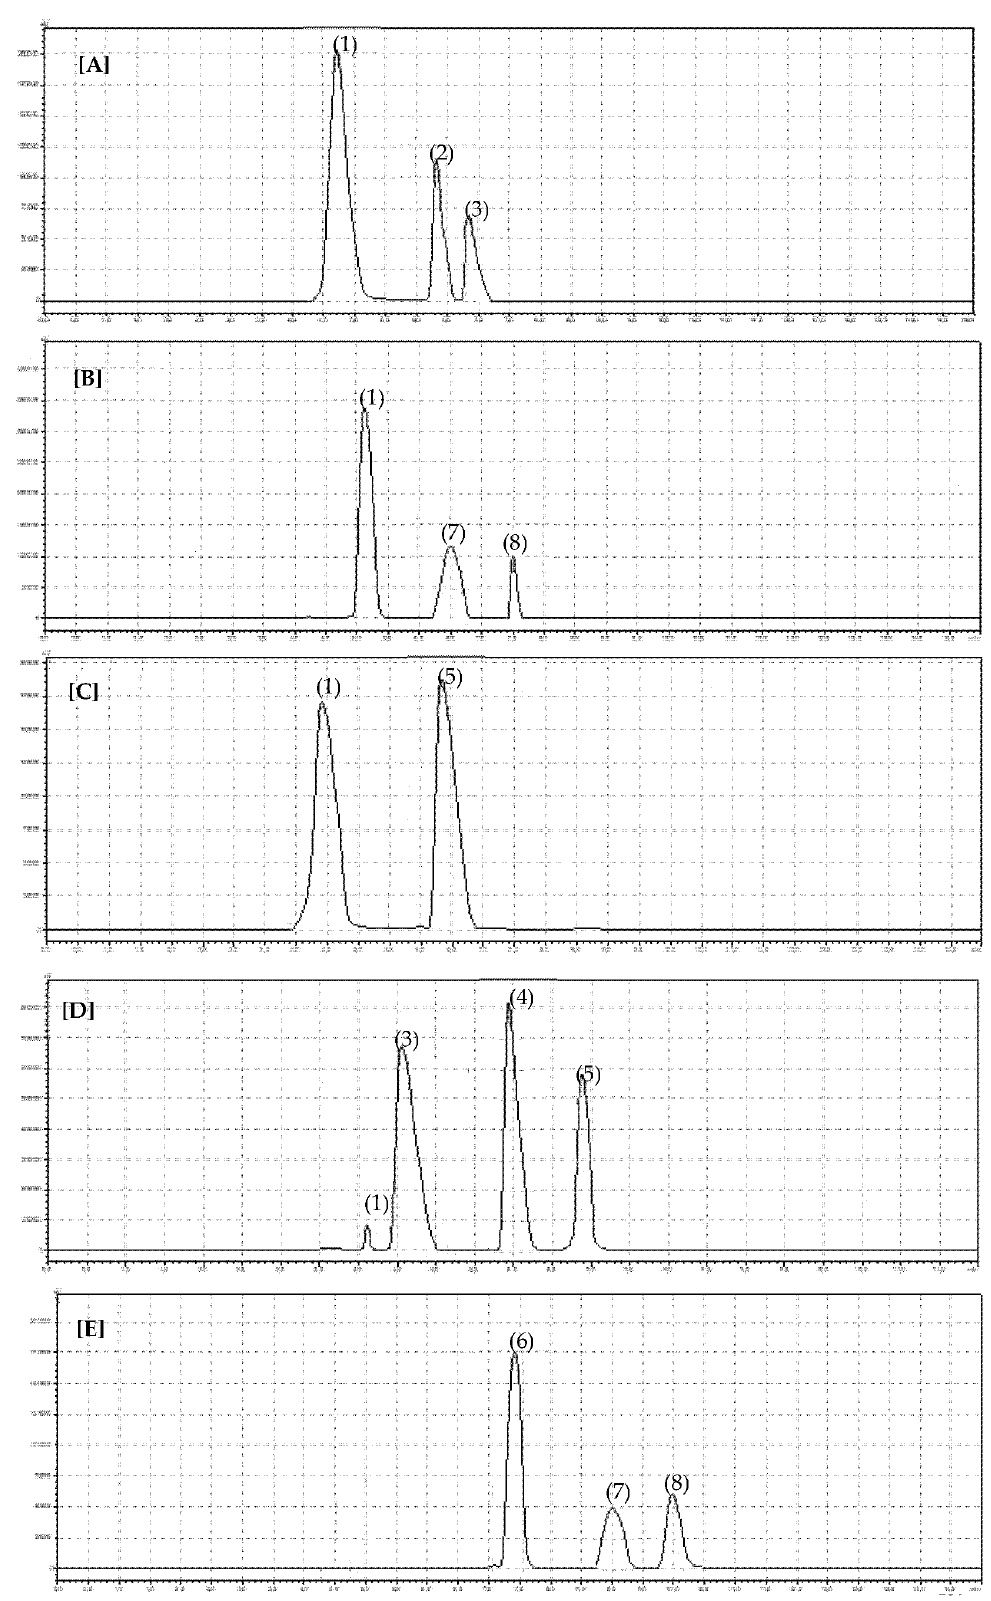
Figure 2. Chromatogram showing retention times for identified anthocyanins in examined berry fruits: ( A ) raspberry, ( B ) blackberry, ( C ) red currant, ( D ) blackcurrant, and ( E ) blueberry. (1) Cy-3-Glu, (2) Pel-3-Glu, (3) Del-3-Glu, (4) Del-3-Rut, (5) Cy-3-Rut, (6) Del-3-Gal, (7) Cy-3-Gal, and (8)